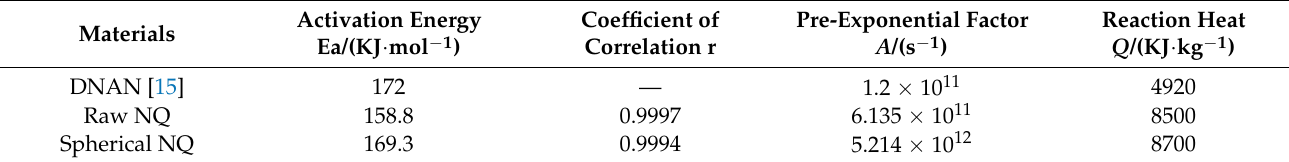
Table 3. Thermal reaction kinetic parameters for the